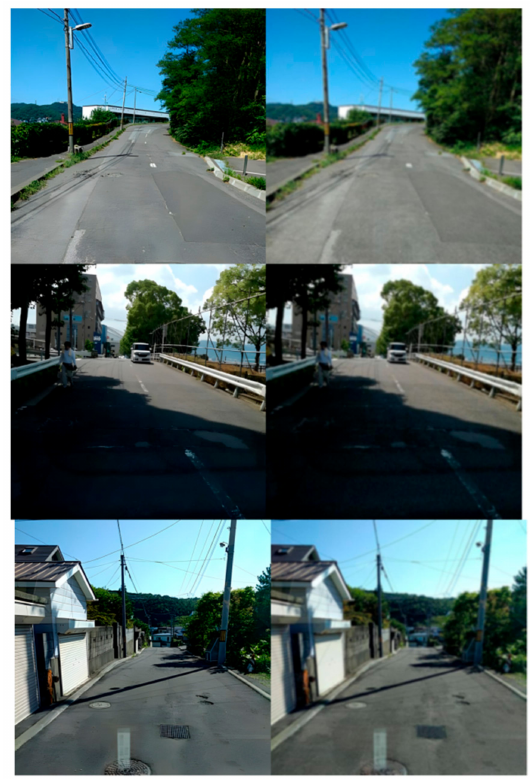
Figure 5. The Japan dataset. Generated SR image is shown on the left and the corresponding LR image on the